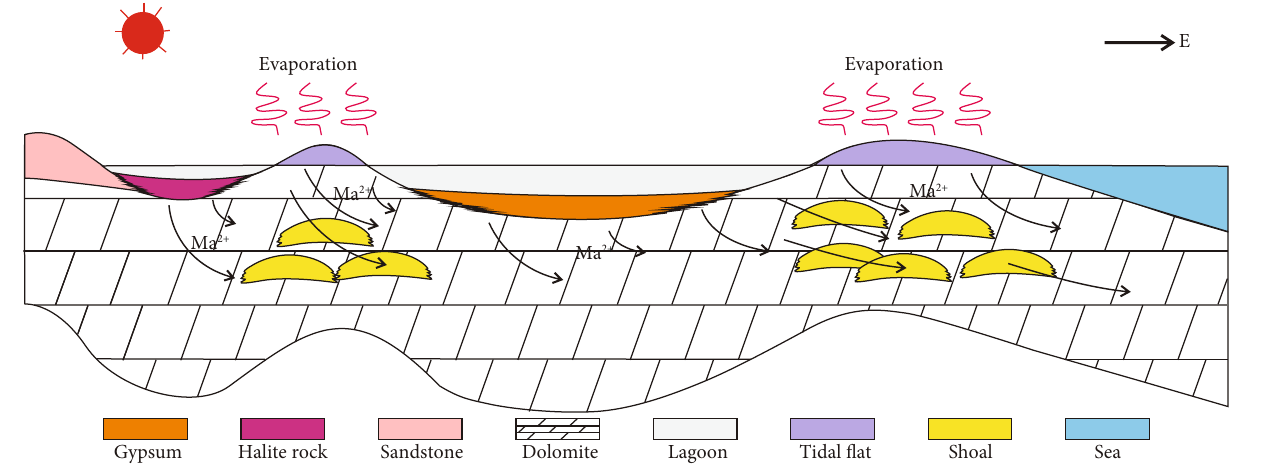
Figure 10: The genetic model of dolomite in